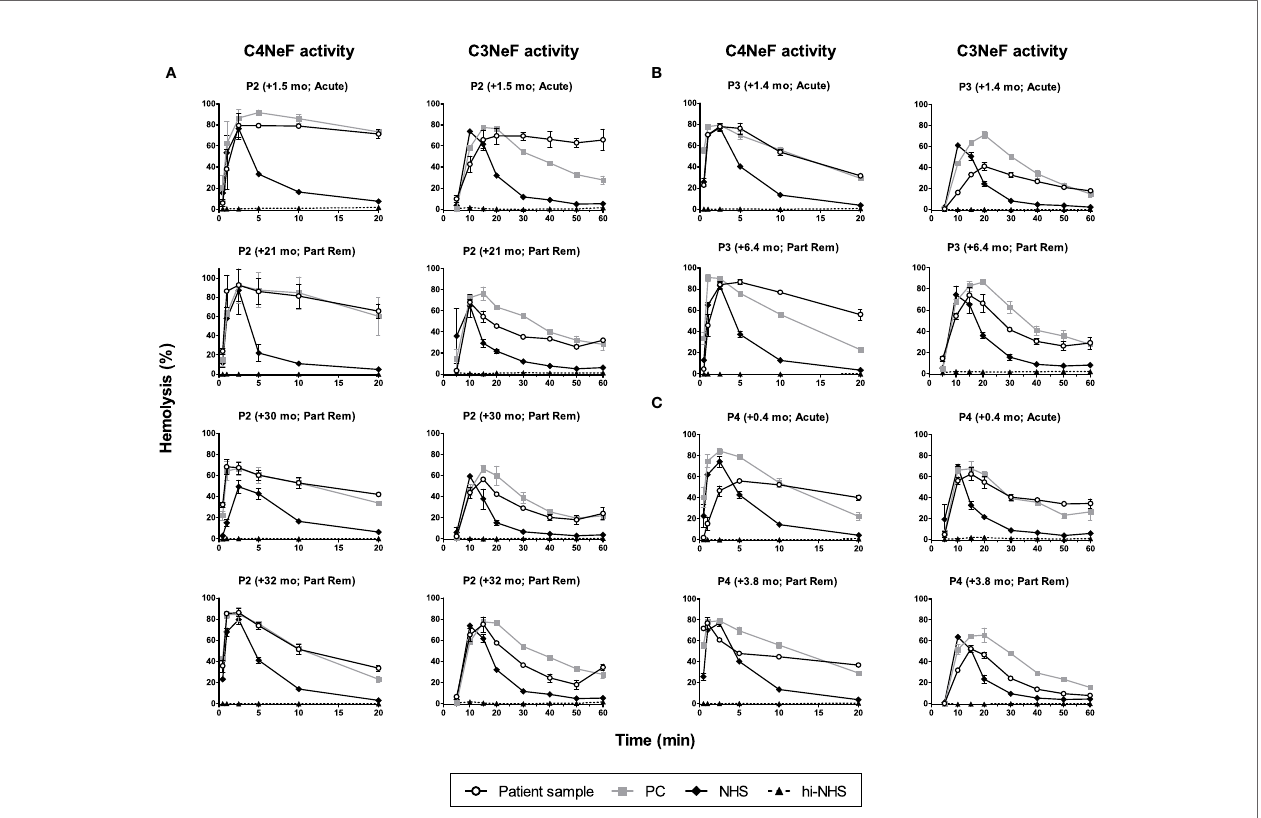
FIGURE 7 | C4 nephritic factor and C3 nephritic factor activity of patients P2, P3, and P4 during follow-up. Samples from P2 (A) , P3 (B) , and P4 (C) collected over the disease course were tested for prolonged classical pathway activity, i.e. C4 nephritic factor (C4NeF) activity, and for prolonged alternative pathway activity, i.e. C3 nephritic factor (C3NeF) activity. Collection dates are presented as time after acute presentation in months (+mo). Hemolysis levels are presented as percentage of full lysis of erythrocytes in water. Results are shown as mean and range of two independent experiments. Part Rem, partial remission; PC, positive control; NHS, normal human serum; hi-NHS, heat-inactivated